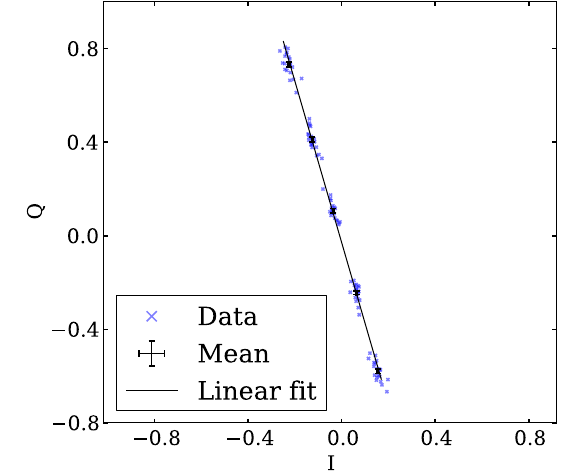
FIG. 14. Fit of the quadrature-phase component of the vertical position cavity signal against the in-phase component during a vertical position scan to measure the IQ rotation angle.